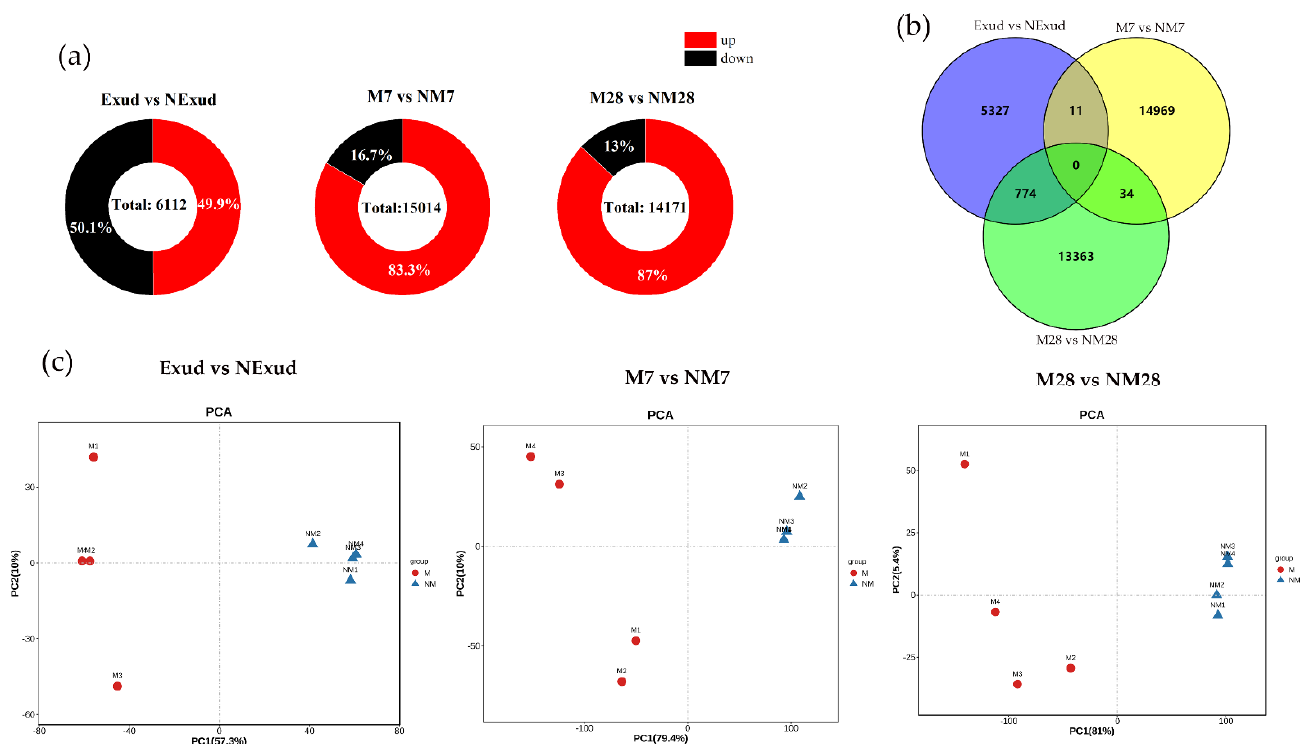
Figure 4. Number of differentially expressed genes (DEGs). ( a ) Pie charts showing the number of significantly upregulated and downregulated DEGs at each timepoint ( p < 0.05); ( b ) Venn diagram showing the number of DEGs that are common to more than one timepoint and the number of genes that are unique to individual timepoints; ( c ) principle component analysis (PCA) of DEGs detected in the Exud vs. NExud treatment, 7 dpi with S. bovinus (M7) vs. the uninoculated (NM7) treatment, and 28 dpi with S. bovinus (M28) vs. the uninoculated (NM28)